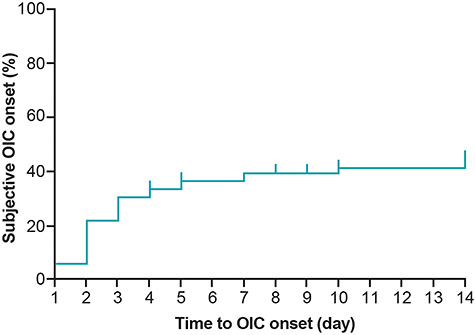
Kaplan–Meier plot of patients’ self-awareness of OIC in patients with lung cancer (FAS1 population). The tick marks in the plot represent censored patients. FAS, full analysis set; OIC, opioid-induced constipation.